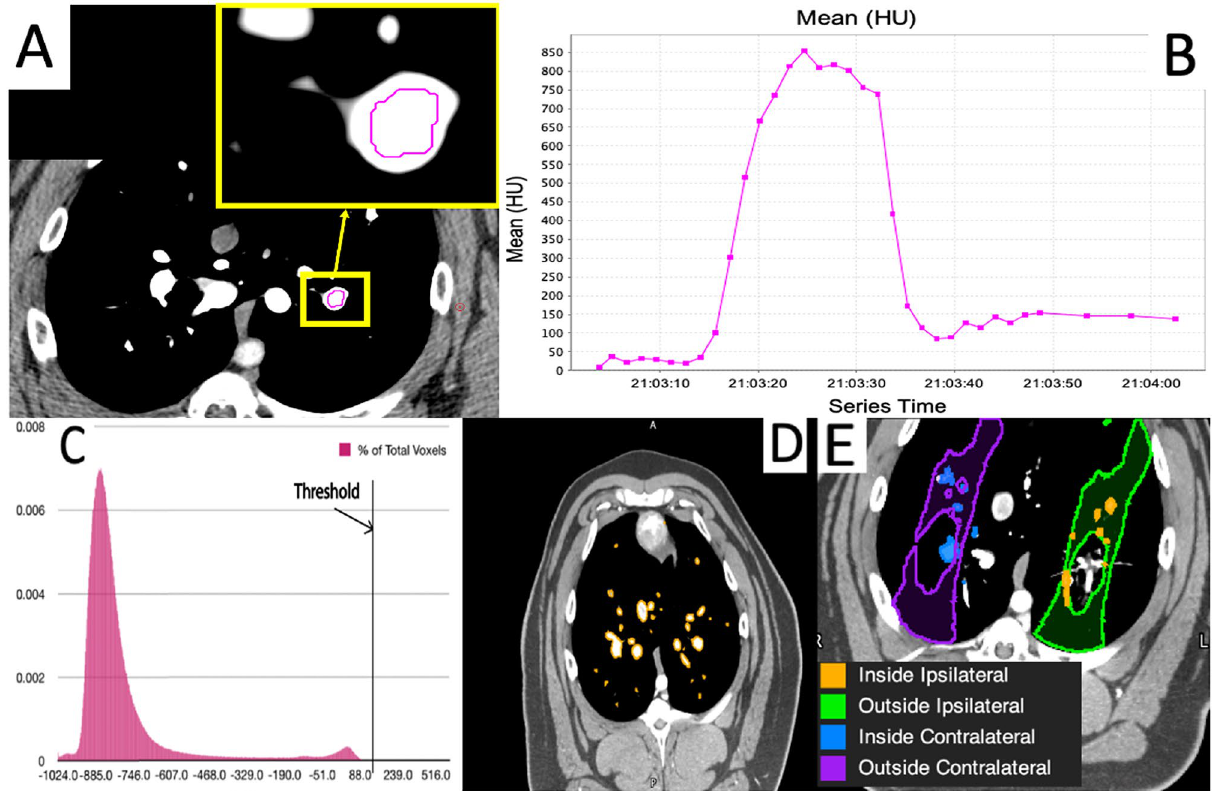
Figure 1. ( A ) Placement of an ROI in a region showing high contrast uptake. ( B ) Plot of the mean HU value in that ROI over the timespan of the dynamic 4DCT scan for a subject. The increase in mean HU shows that contrast is flowing in and out of this vessel. ( C ) Histogram of HU values over the entire lung mask. A threshold was established based on the second mode and was placed 2 standard deviations from the mean of the second mode. ( D ) Example scan slice showing vasculature segmented using the threshold. ( E ) Example scan slice showing the four different contours created for each dose bin to perform